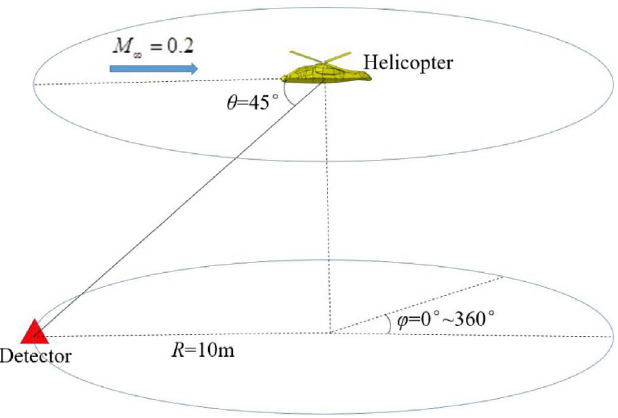
Figure 5. Schematic of simulation